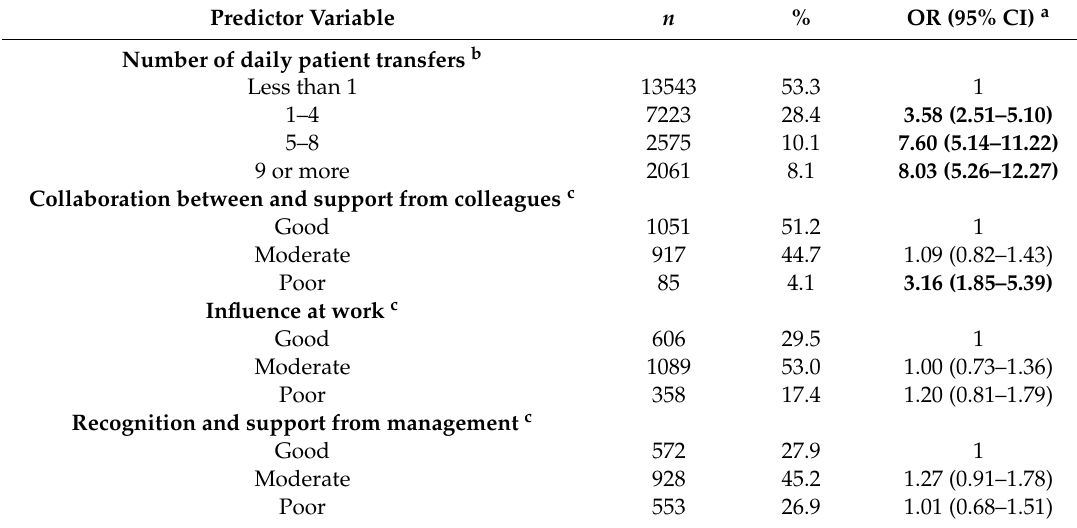
Table 2. Odds ratios and 95% confidence intervals for the risk of back injury events during the 1-year follow-up period. All predictor variables are mutually adjusted. Statistically significant findings are marked in